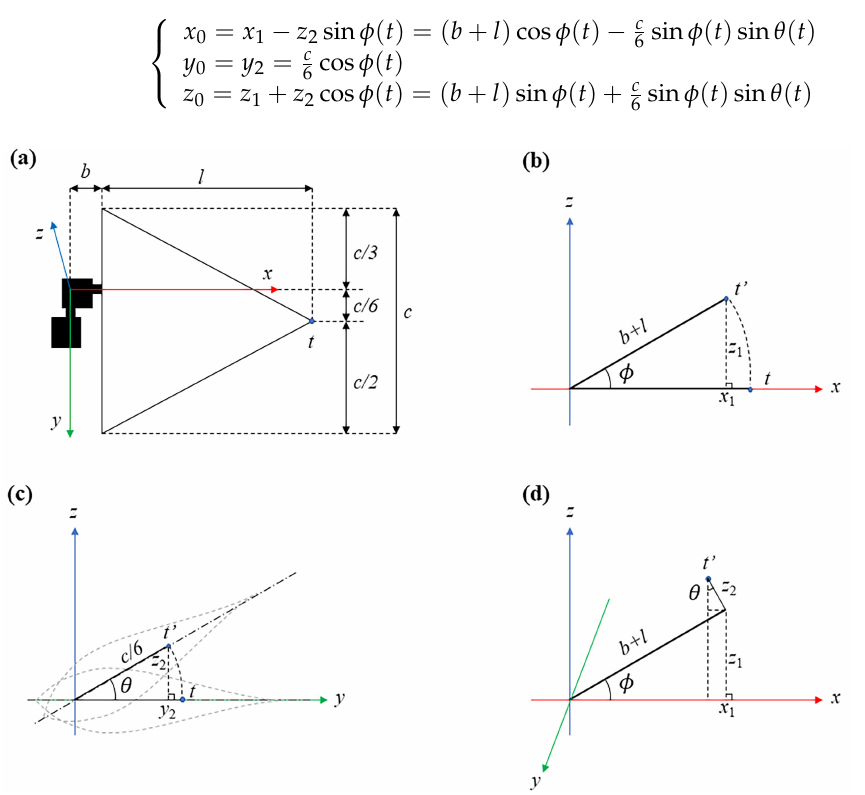
Figure 7. The kinematics analysis of the flapping wing. ( a ) Top view of the flapping wing. ( b ) Roll motion at plane XoY . ( c ) Pitch motion at plane XoZ . ( d ) Combined motion in three-dimensional coordinate